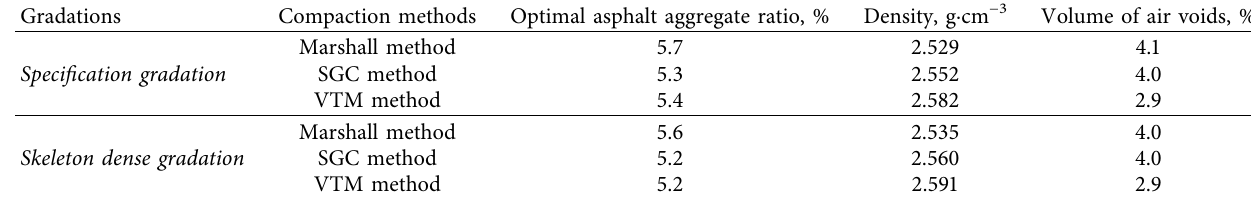
Table 7: Design results of different compaction